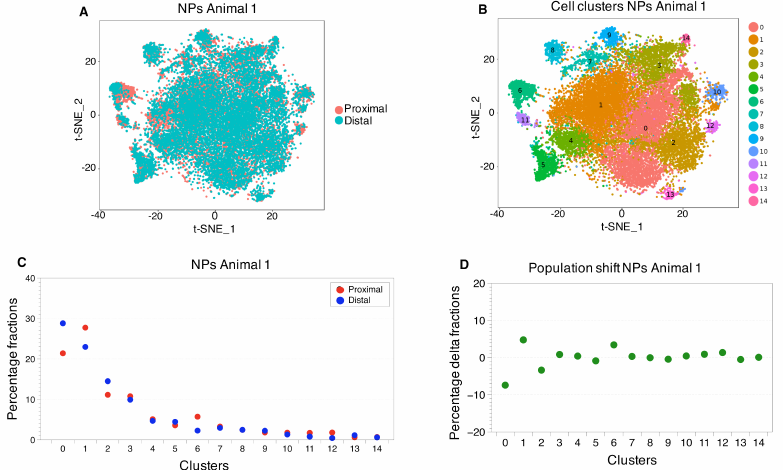
Figure 2. Cell cluster size correlation. The graphical alignment of cell cluster sizes within the NPs ( A ) and the AFs ( B ) shows a high correlation (r > 0.85) within the datasets. The numbers placed around the piechart are cell cluster numbers, with the largest cluster starting at number zero. Each ring represents one sample and each color within the ring represents one cluster.